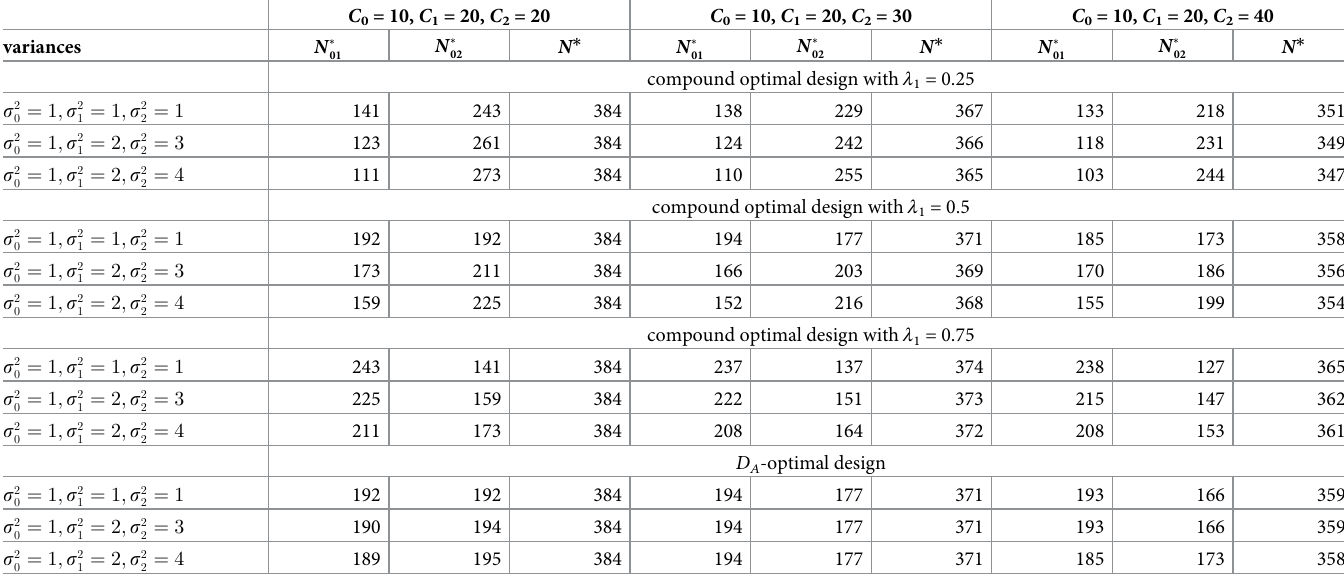
Table 1. Optimal sample sizes for the incomplete within–subject design with scenario 1.